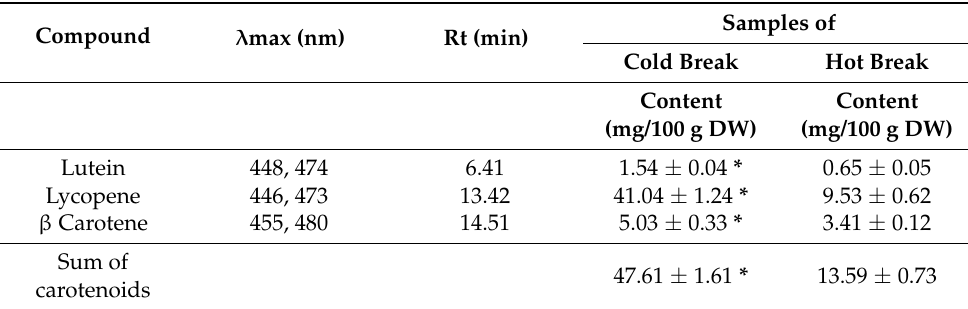
Table 1. Individual and sum of carotenoids identified in tomato peels derived from cold break and hot break processing lines, determined by high performance liquid chromatography (HPLC) with a diode array detector and expressed as mg/100 g DW; analytical measurements were conducted with three replicates ( n =